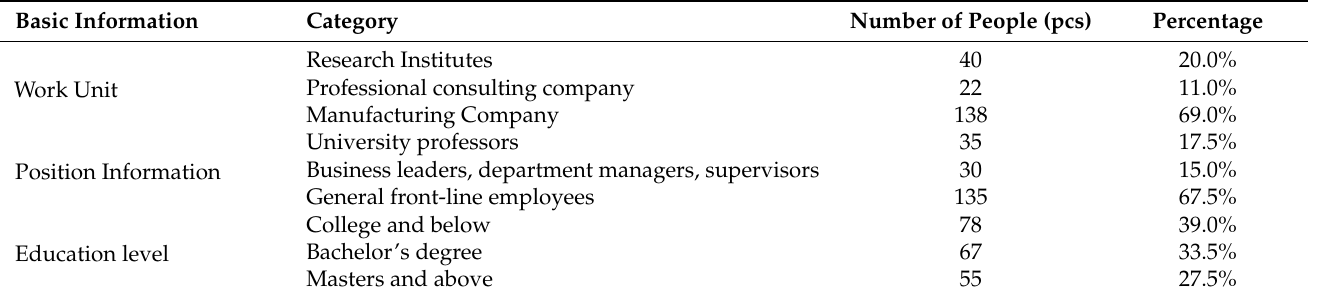
Table 3. Distribution of respondents’ basic information.